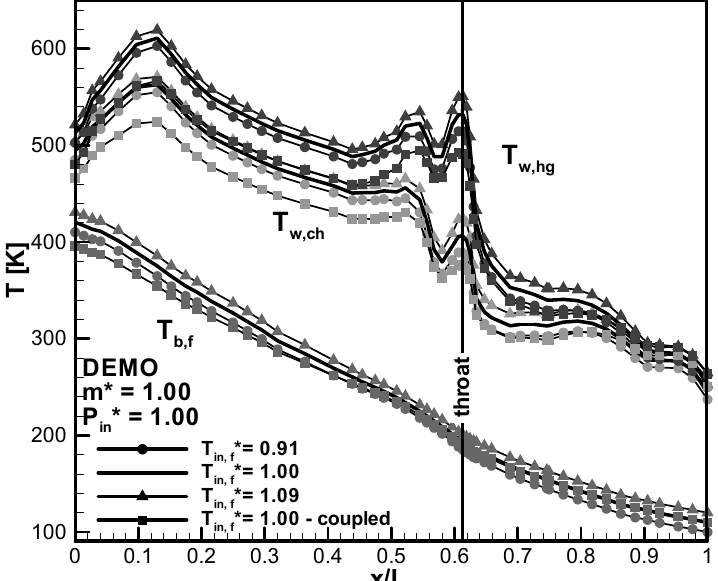
Figure 9. Axial profiles of hot-gas-wall temperature, temperature of channel bottom wall and fluid bulk temperature, considering different values of inlet fluid temperature (runs 1-4).